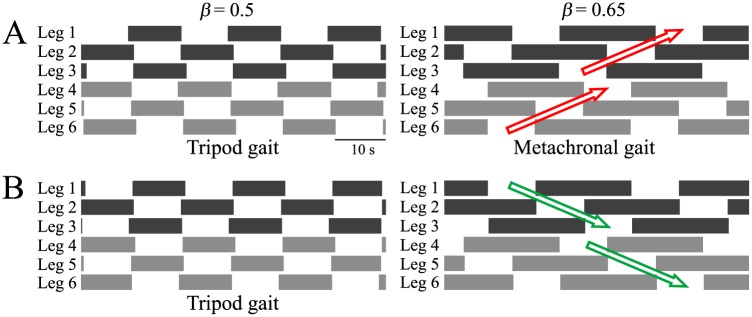
Footprint diagrams of the gaits obtained at duty factors of β = 0.5 and 0.65 in computer simulations.A: Direct wave gait. B: Retrograde wave gait.